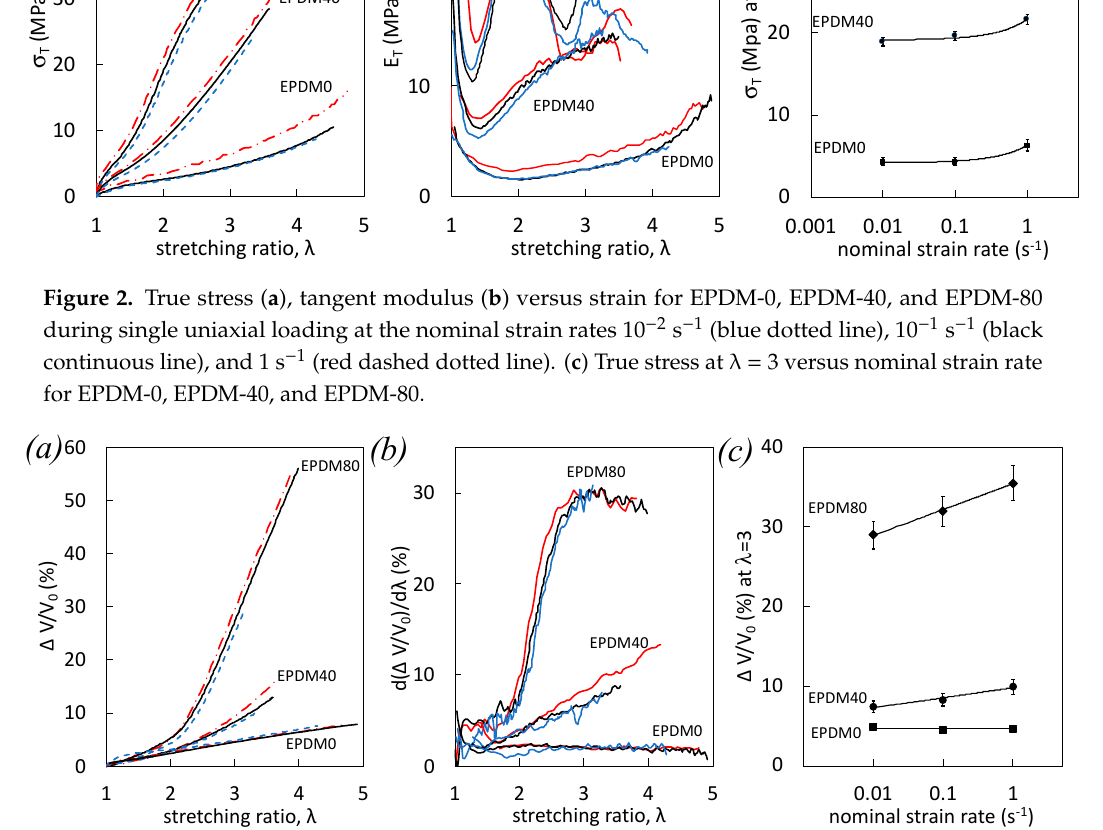
Figure 3. Volumetric strain ( a ) and rate of volumetric strain ( b ) versus strain for EPDM-0, EPDM-40, and EPDM-80 during single uniaxial loading at the nominal strain rates 10 − 2 s − 1 (blue dotted line), 10 − 1 s − 1 (black continuous line), and 1 s − 1 (red dashed dotted line). ( c ) Volumetric strain at λ = 3 versus nominal strain rate for EPDM-0, EPDM-40, and EPDM-80.